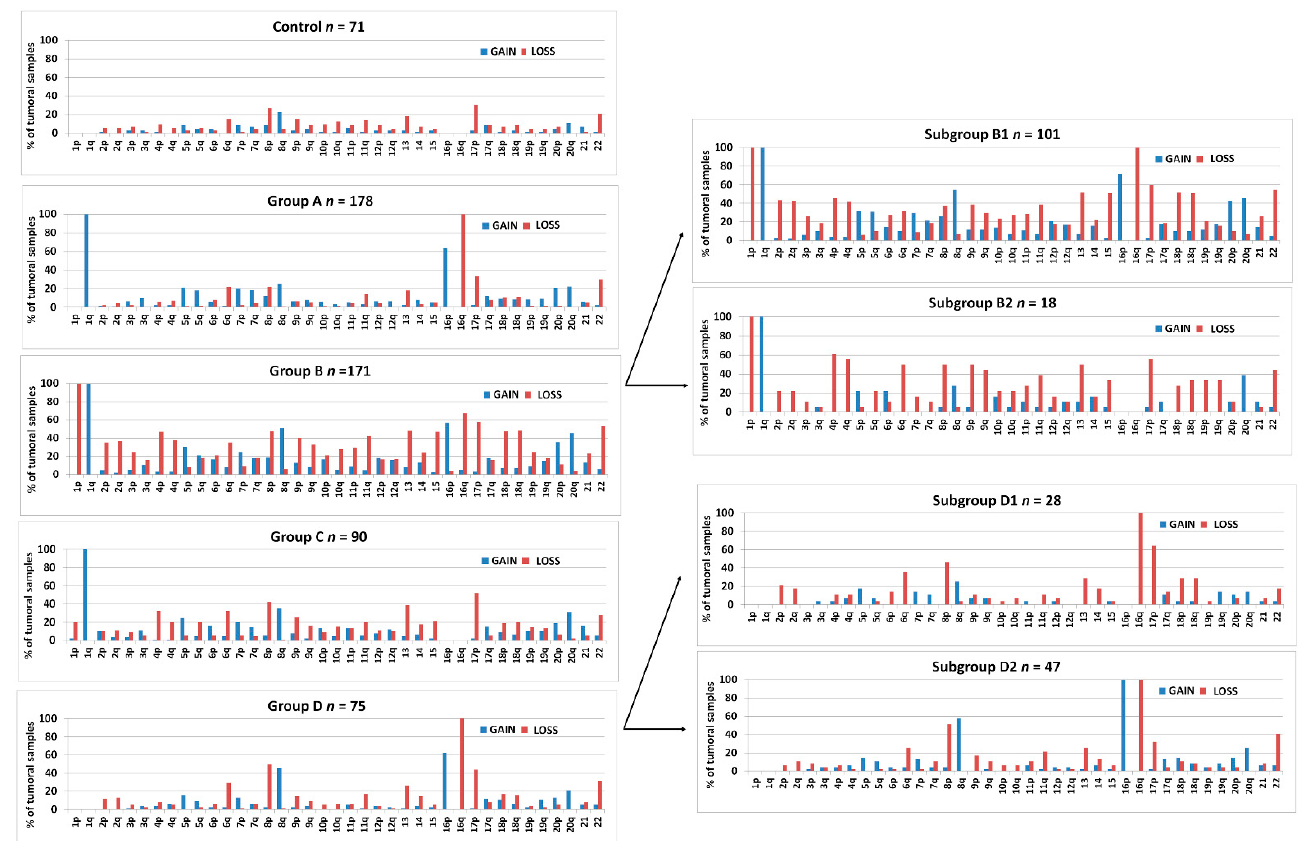
Figure 3. Bar graphs showing the percentage of samples bearing arm-level gains or losses in chromosomes 1–22 in the different 1,16-chromogroups (A, B, C, D, B1, B2, D1, D2, and control) of BRCA samples. The number of samples ( n ) in each group is reported in the corresponding graph.